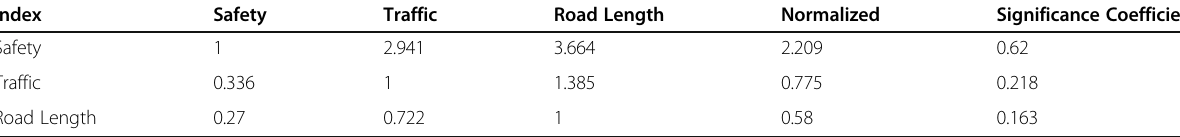
Table 4 Paired comparison matrix of the main indices